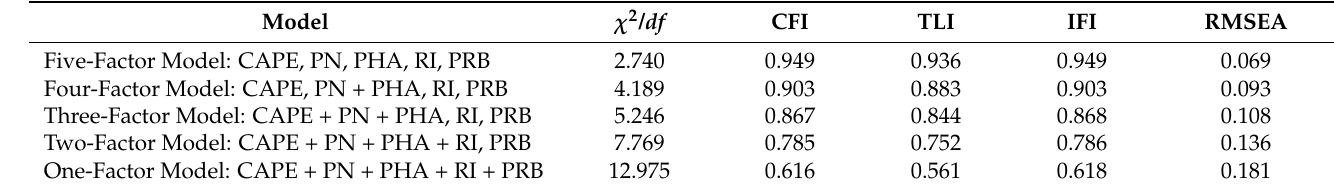
Table 1. Confirmatory factor analysis